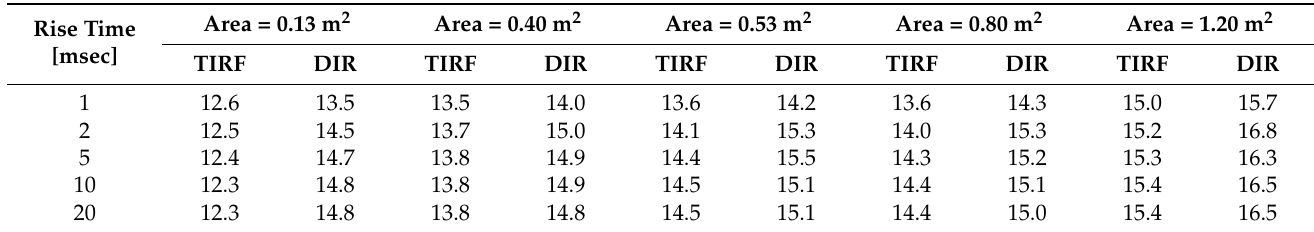
Table 12. Ultimate dynamic shear capacities of Model 3 using TIRF with linear boundary condition and DIR with nonlinear boundary condition (unit: bar).